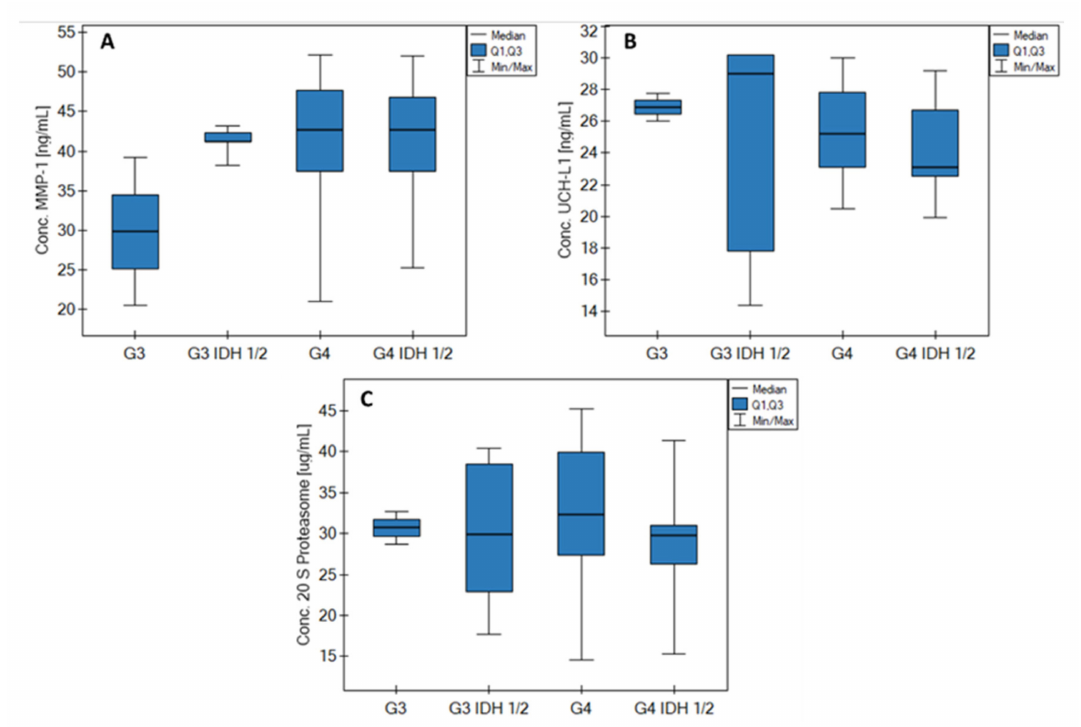
Figure 6. Impact of IDH status on biomarkers (A) MMP-1; (B) UCH-L1 and (C) 20S